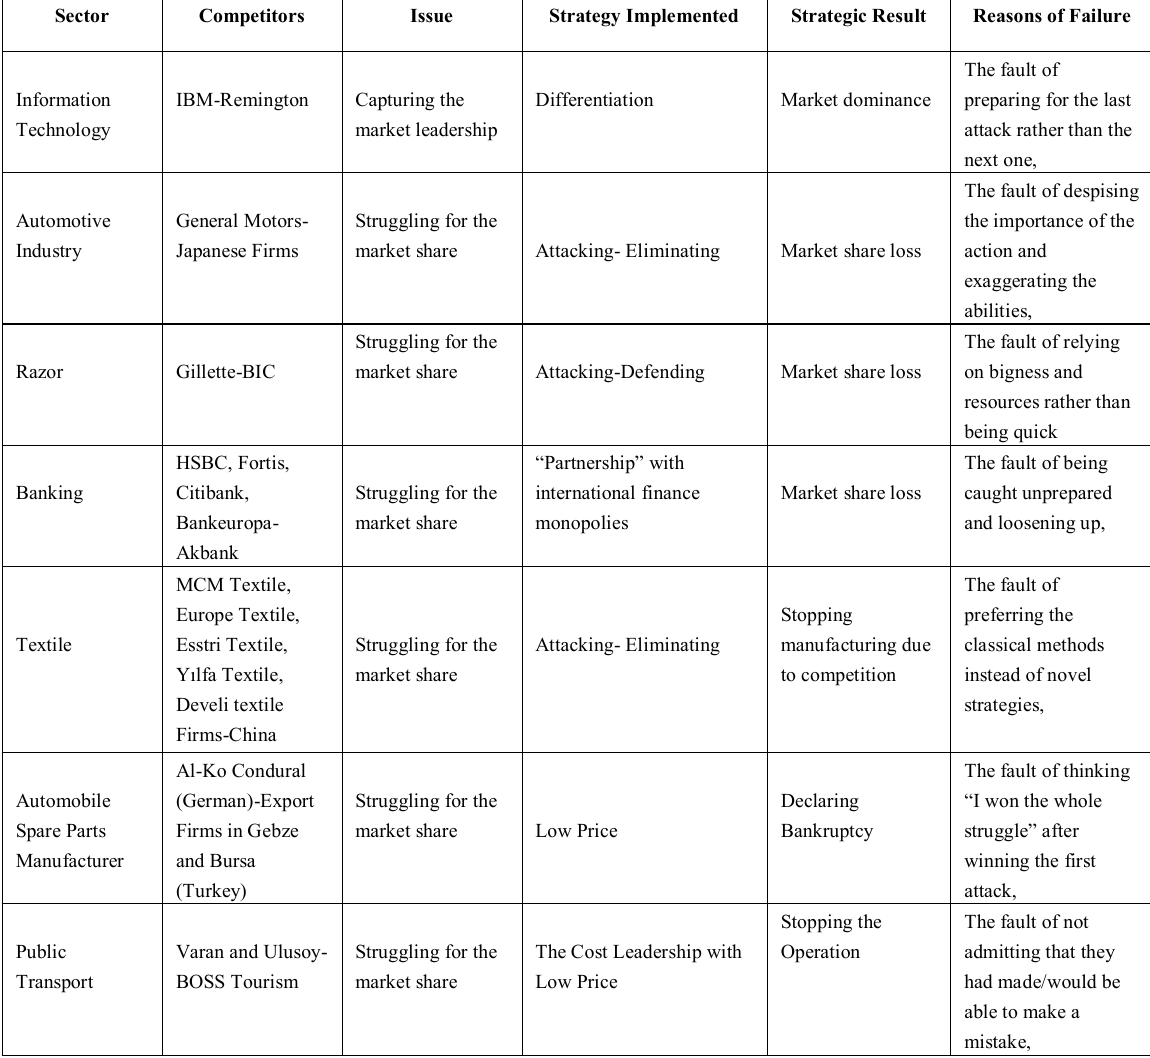
Table 3: Examples of War in the Business World and Reasons of Failure in the Competition